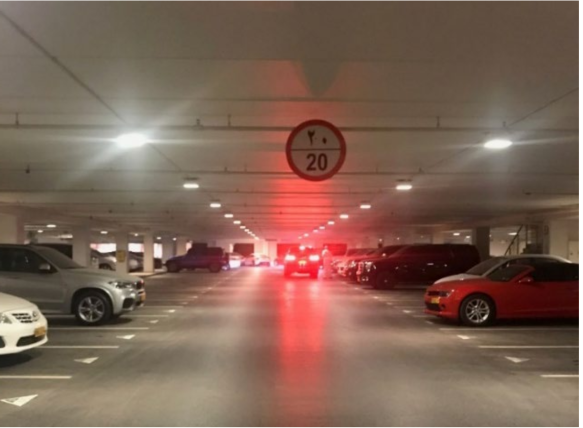
Figure 7. Speed limit in the parking garage practiced in Middle East region (e.g., Oman).